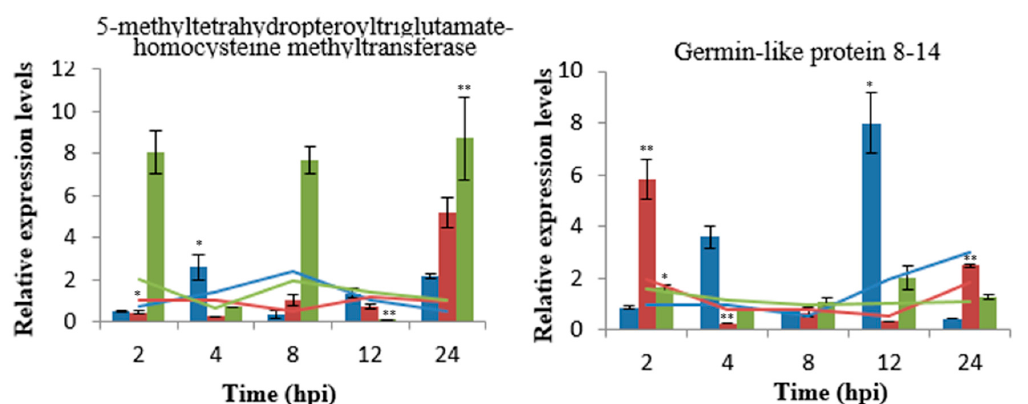
Figure 7. Quantification of six gene transcripts and protein levels at different time points post inoculation with Bgt in wheat. The bar graph shows the fold changes of the mRNA expression levels in inoculation vs control samples at five time points. The blue, red, and green columns are representatives of wheat L699 , Neimai836 , and Chuannong26 , respectively. The lines show the fold changes of the protein expression levels in inoculation vs control samples at five time points. The blue, red, and green lines are representatives of wheat L699 , Neimai836 , and Chuannong26 , respectively. The mRNA expression levels were quantified by qRT-PCR normalized against 18S rRNA . Asterisks indicate statistically significant differences (*, p < 0.05; **, p < 0.01) of mRNA expression levels between the inoculation and control samples.